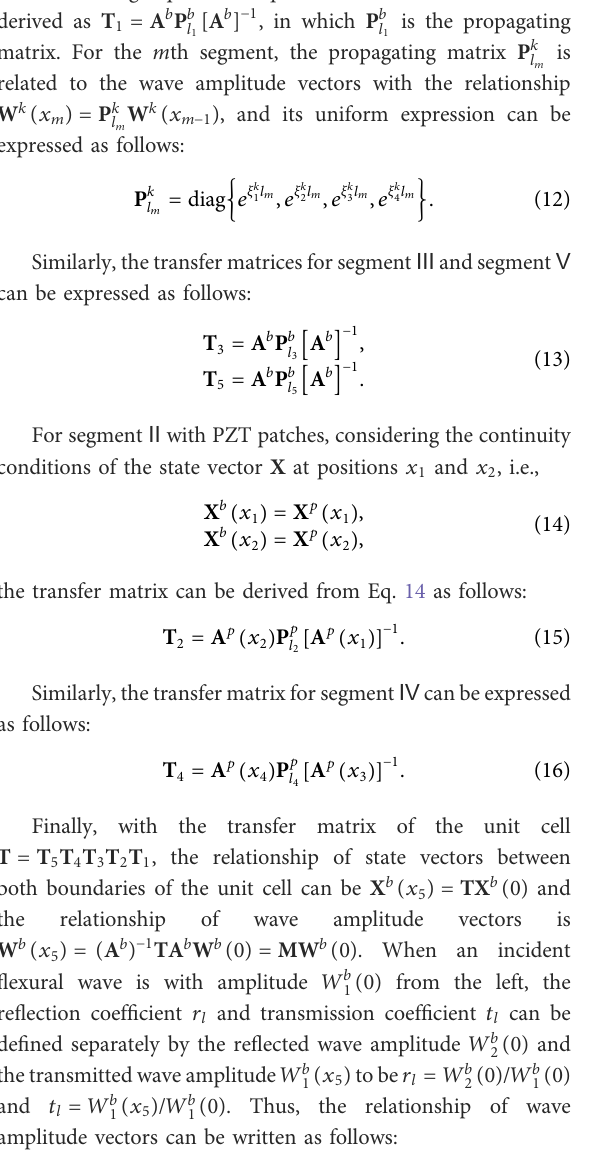
Figure 2. Without resistances in shunted circuits, as shown in Figure 2A, | α | remains constant and is equal to 1 for indicating | r | (cid:2) | r | . For the two circuits with the same non-zero resistance, for l r example, R 1 (cid:2) R 2 (cid:2) 100 Ω , | α | is changed with varying inductances